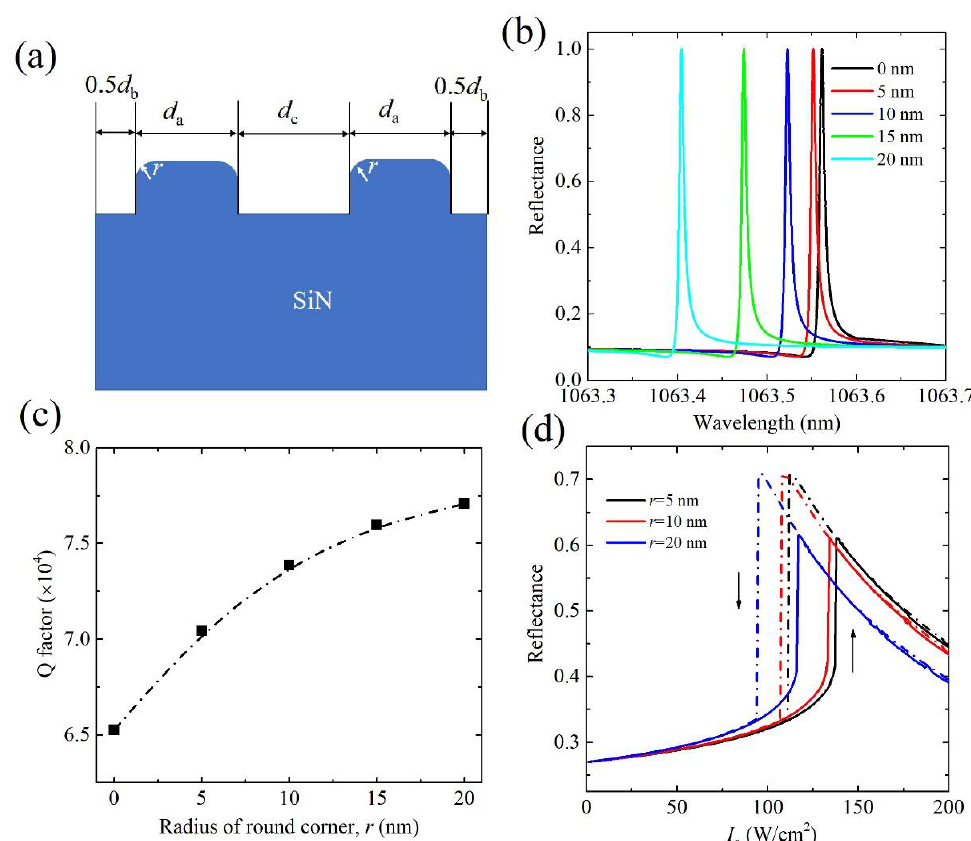
Figure 6. ( a ) Schematic of a unit cell of the GMR nanostructure when the rectangular cross section of grating is deviated. ( b ) Reflectance spectra, ( c ) Q -factor and ( d ) optical bistability in GMR structures ( δ = 0.1) of different radii of round corners at θ = 1°.